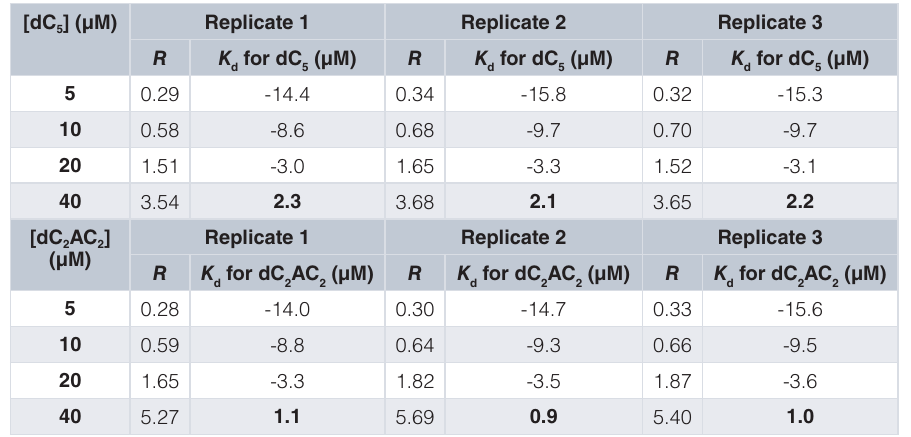
) calculated at each d